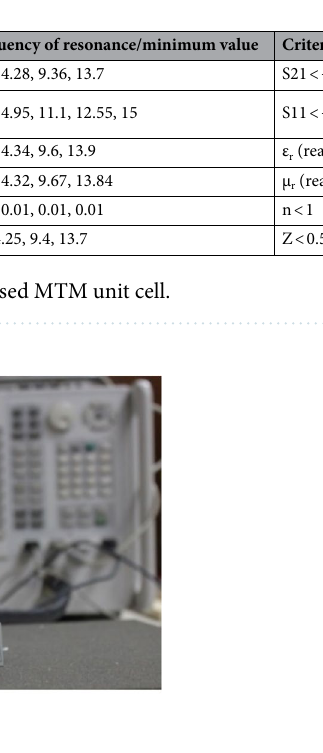
Figure 20. ( a ) Fabricated unit cell ( b ) transmission coefficient measurement setup.